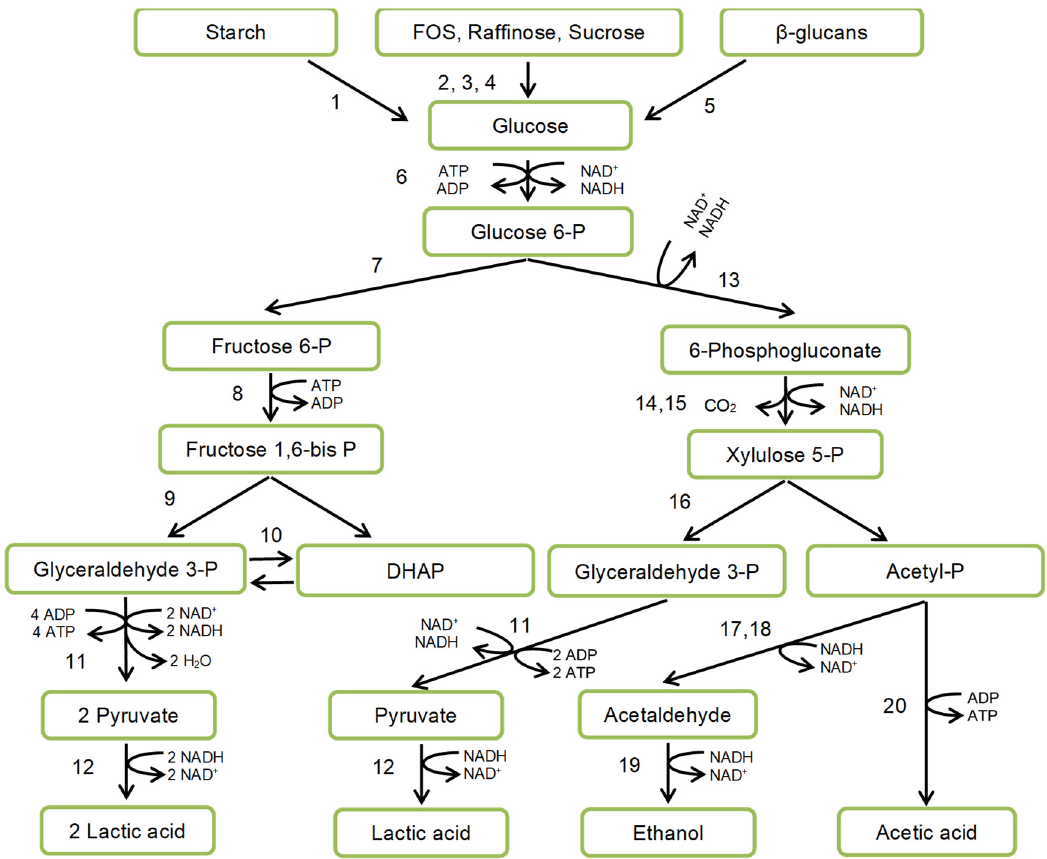
Figure 3. Scheme of lactic acid fermentation. Designations: DHAP—dihydroxyacetone phosphate;